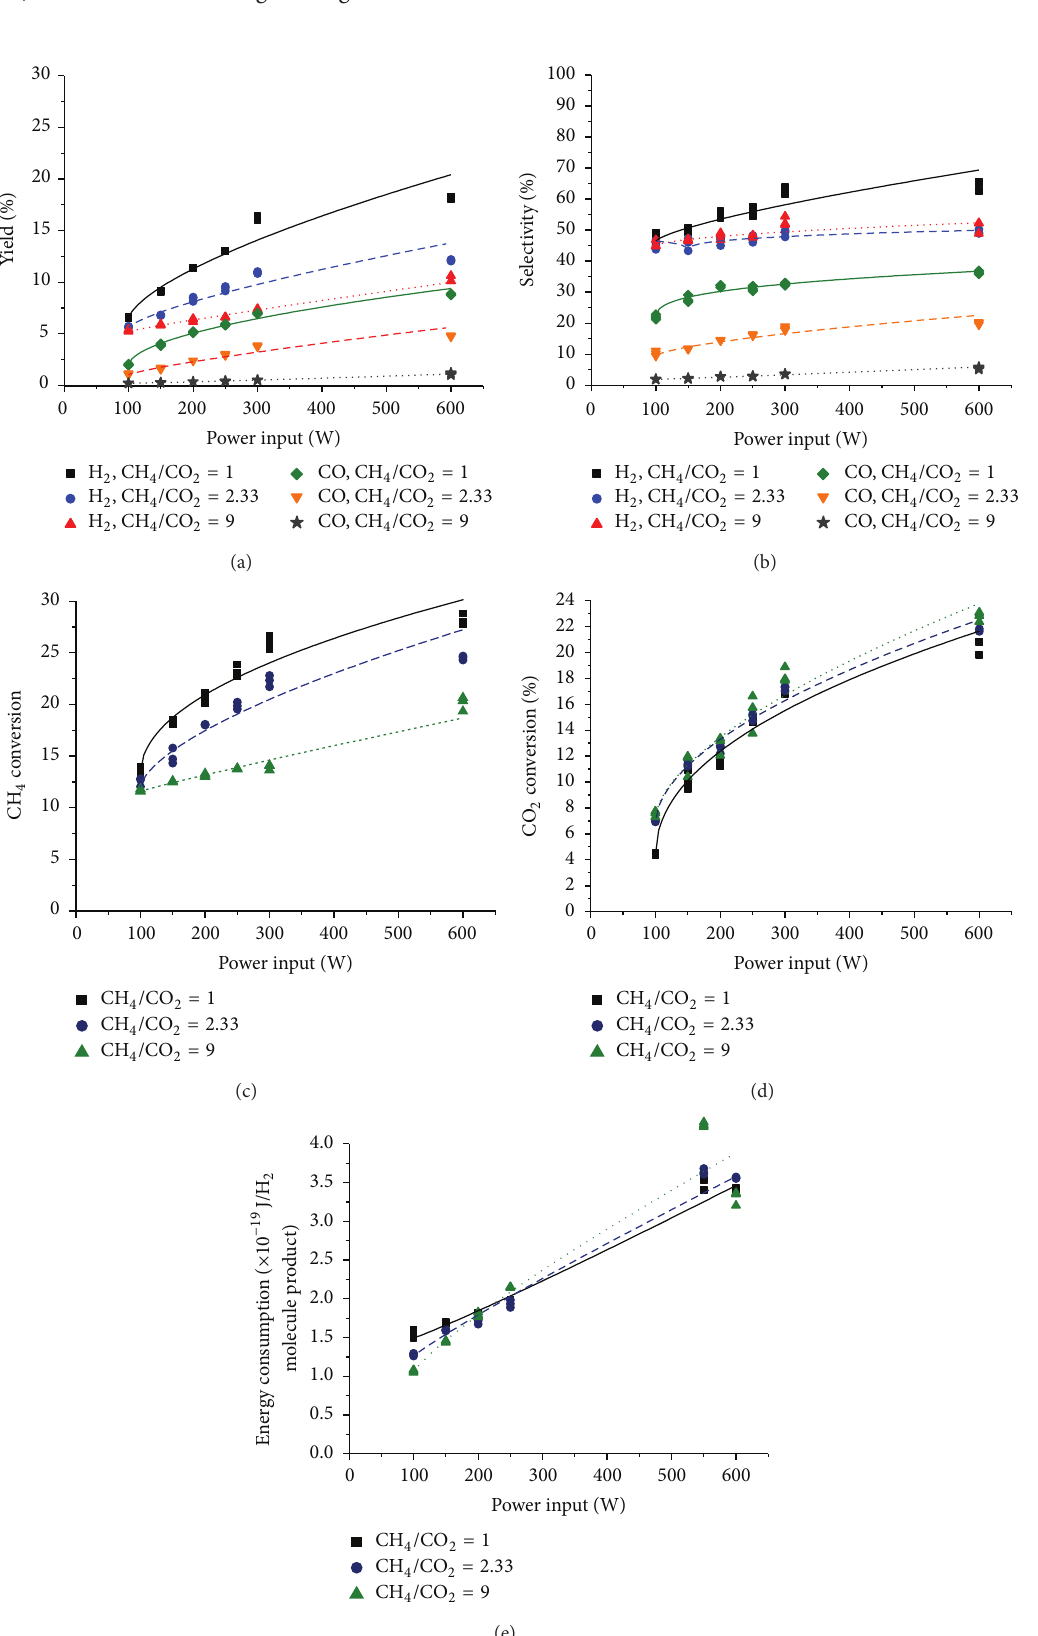
Figure 2: Effect of power input on biogas reforming